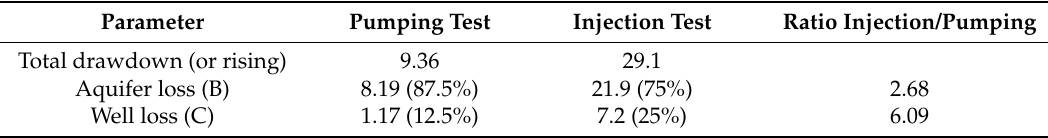
Table 2. The calculated aquifer loss (B) and well loss (C) at 150 m 3 /hour